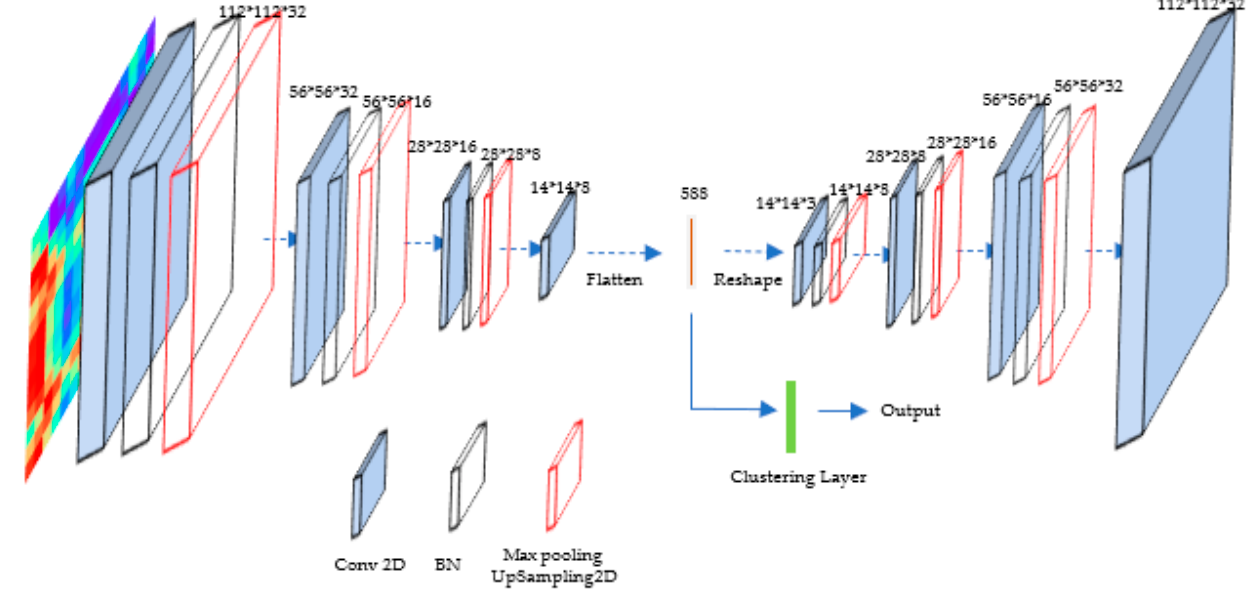
Figure 9. The structure of the proposed DC.